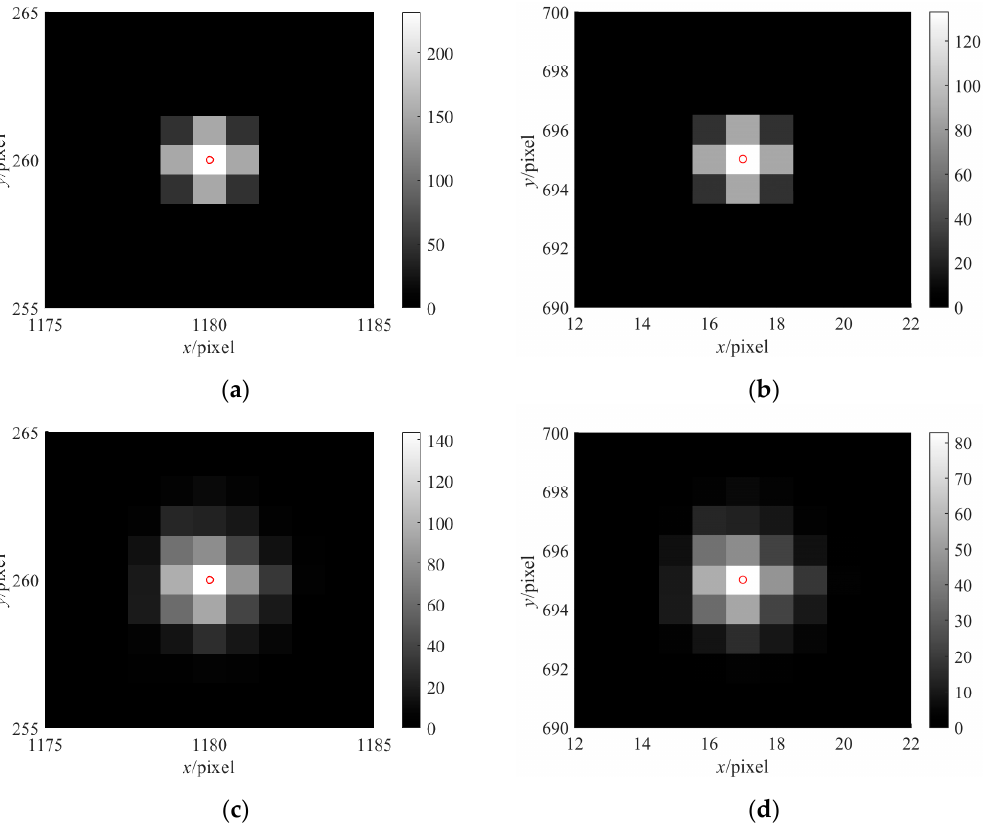
Figure 11. Simulation of distorted star maps: ( a ) star A at 15 km; ( b ) star B at 15 km; ( c ) star A at 5 km; ( d ) star B at 5 km.